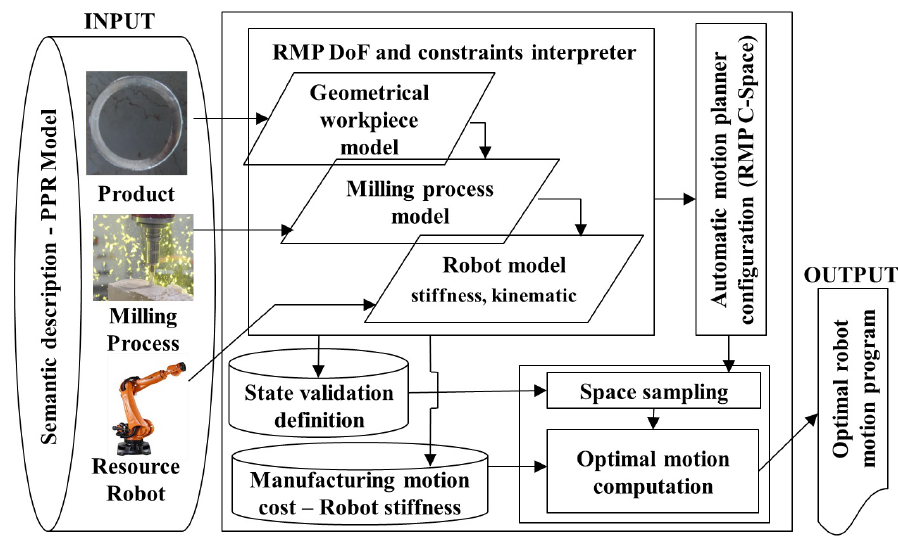
Figure 1. Architecture for the automatic offline motion generation optimizing stiffness for robotic milling (DoF: Degrees of Freedom).